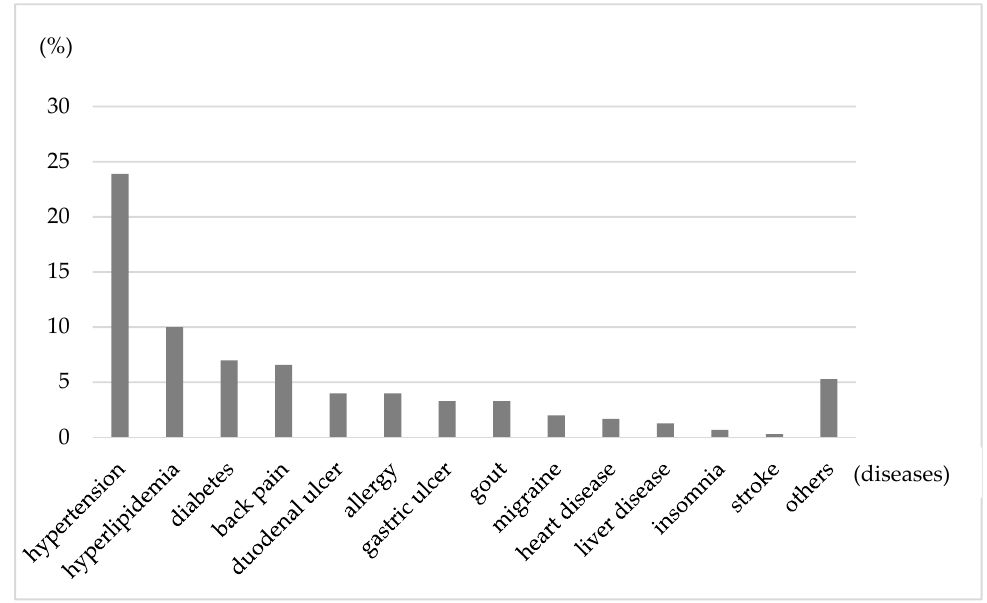
Figure 2. Prevalence of diagnosed diseases and medical conditions reported by bus drivers .